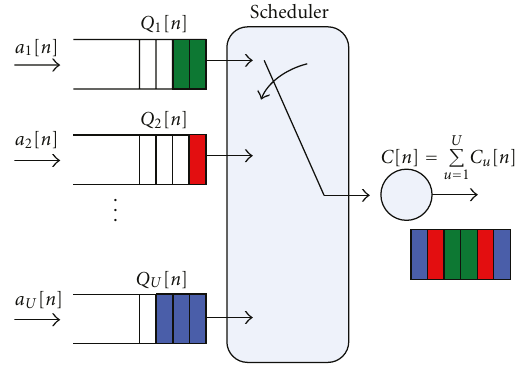
Figure 1: Multiuser system